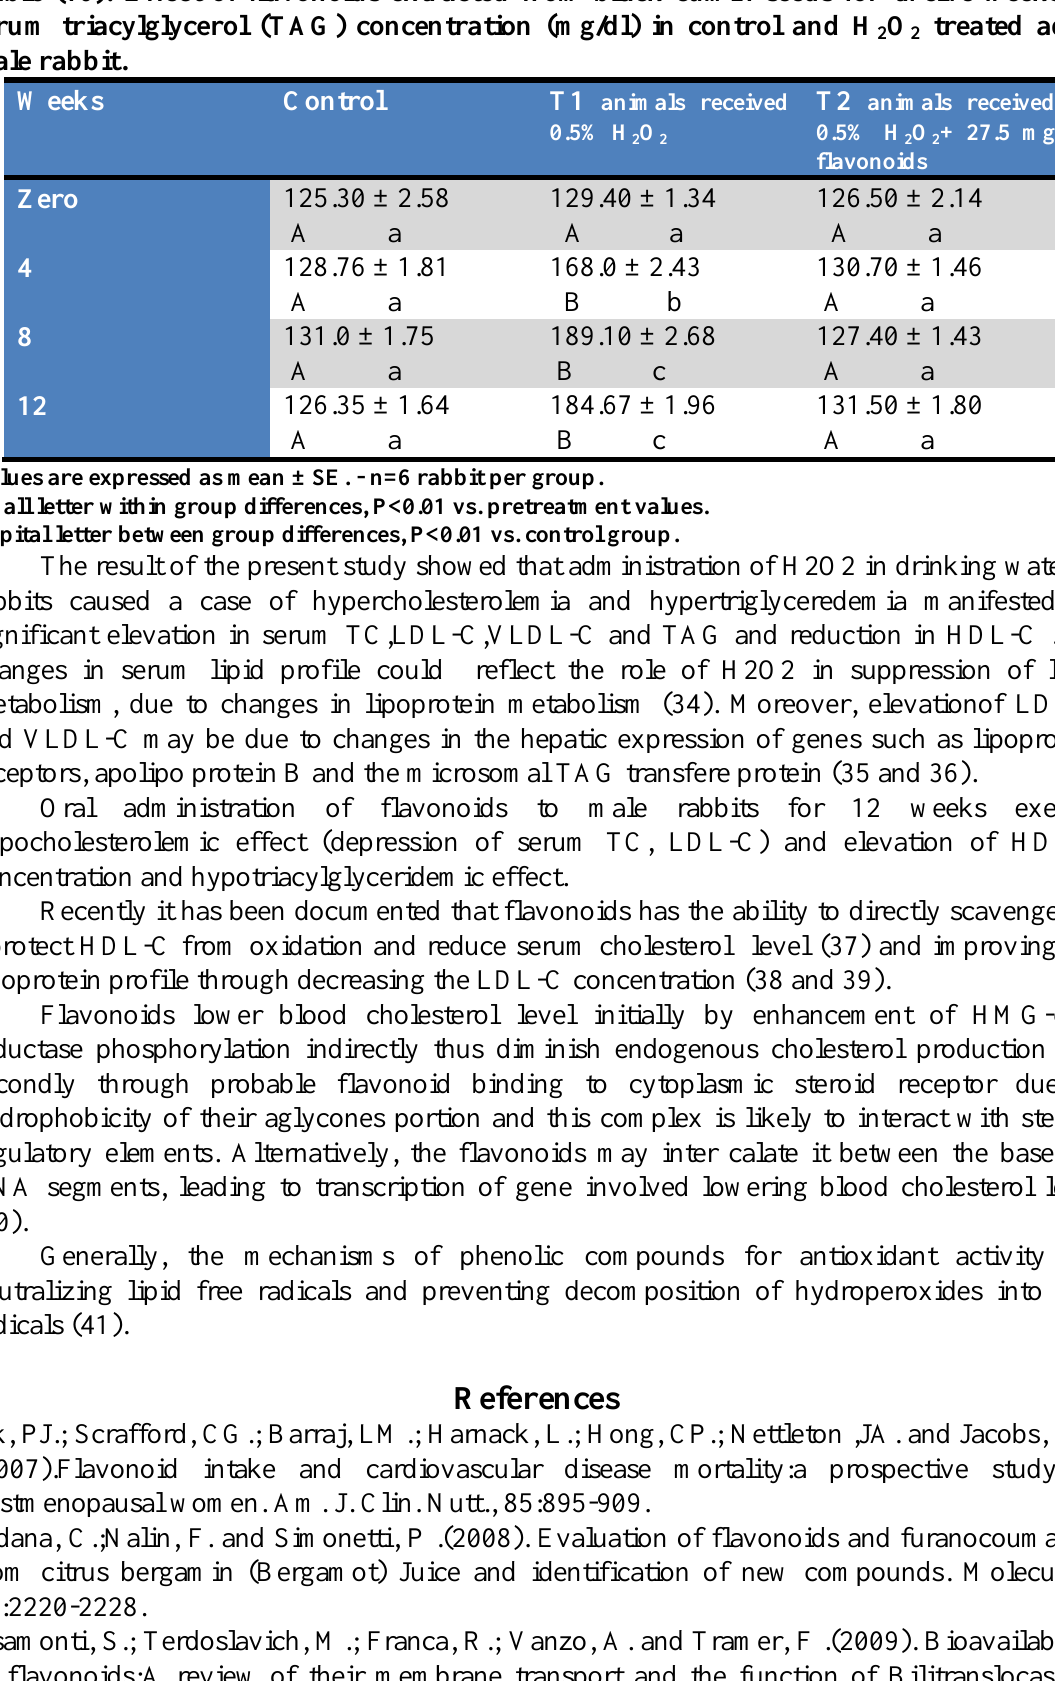
O treated adult 2 2